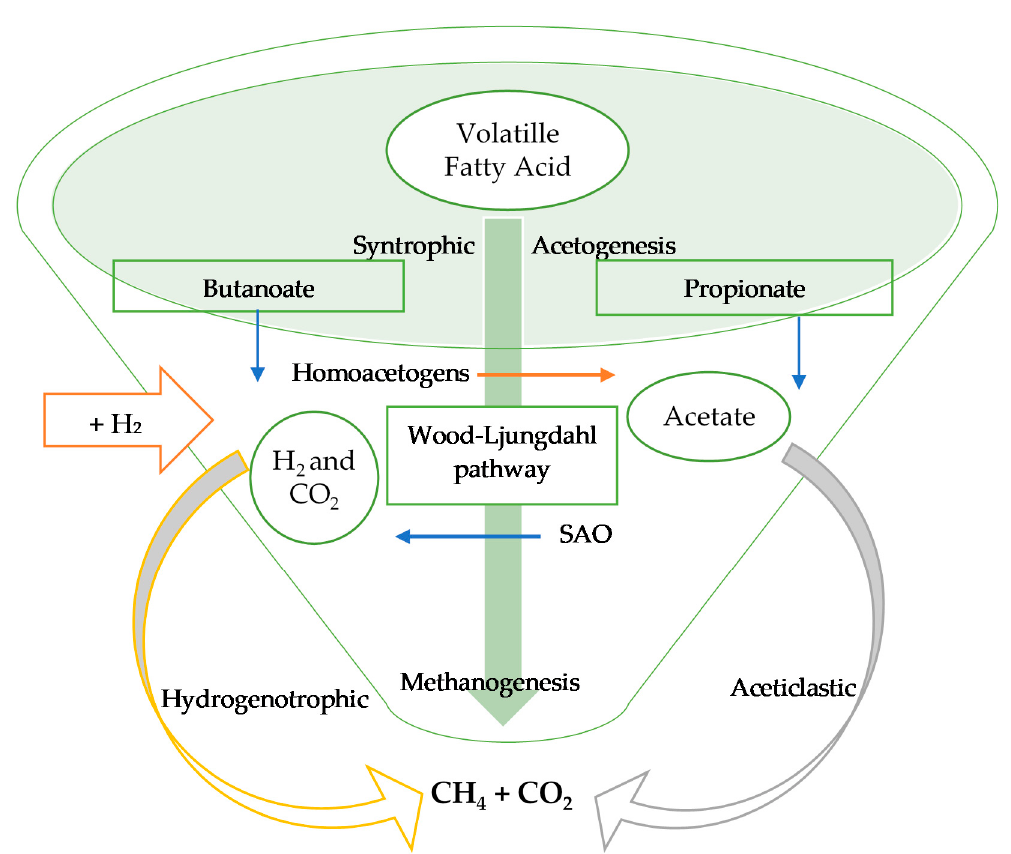
Figure 7. Metabolic pathways for hydrogen assisted methanogenesis [25]. Table 3. In-situ enriched H 2 upgrading technologies.